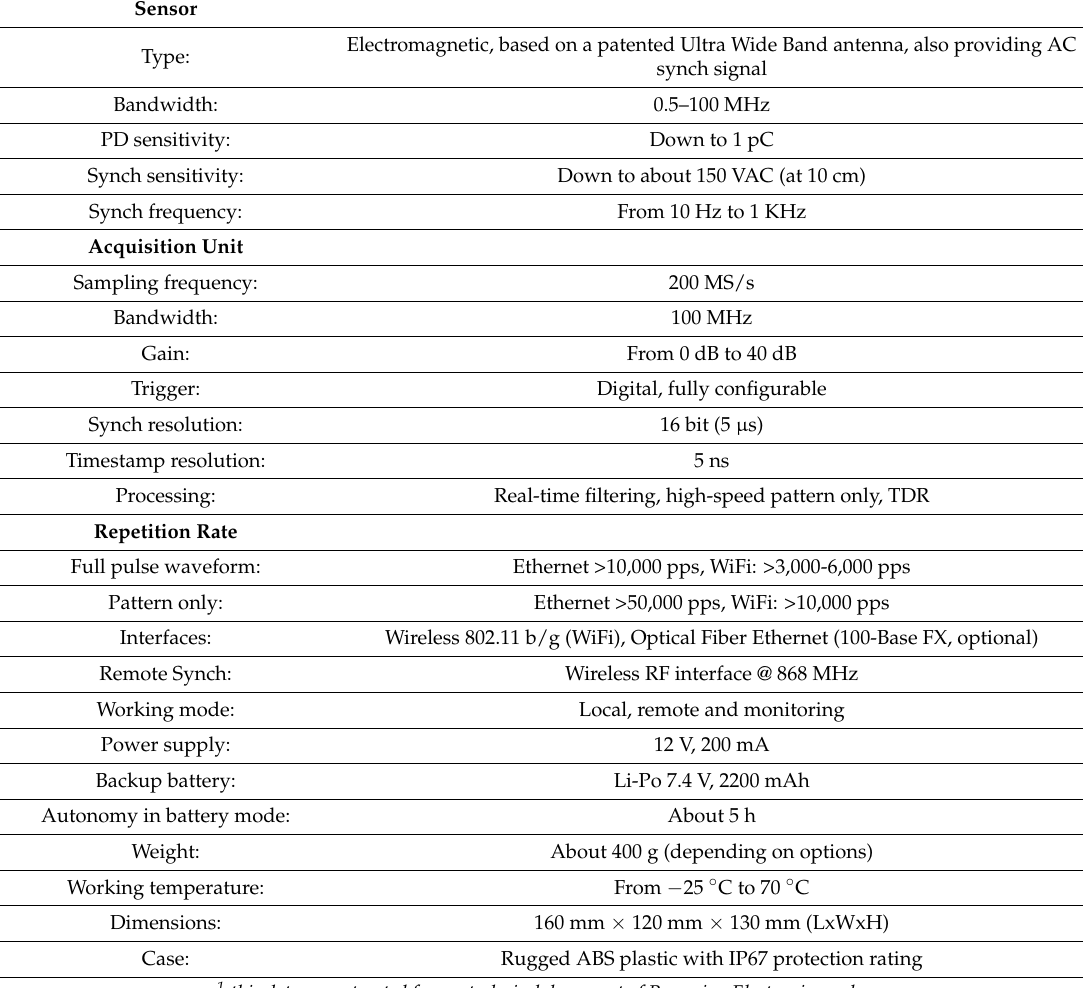
Table 1. Hardware specifications 1 of the Pry-Cam TM